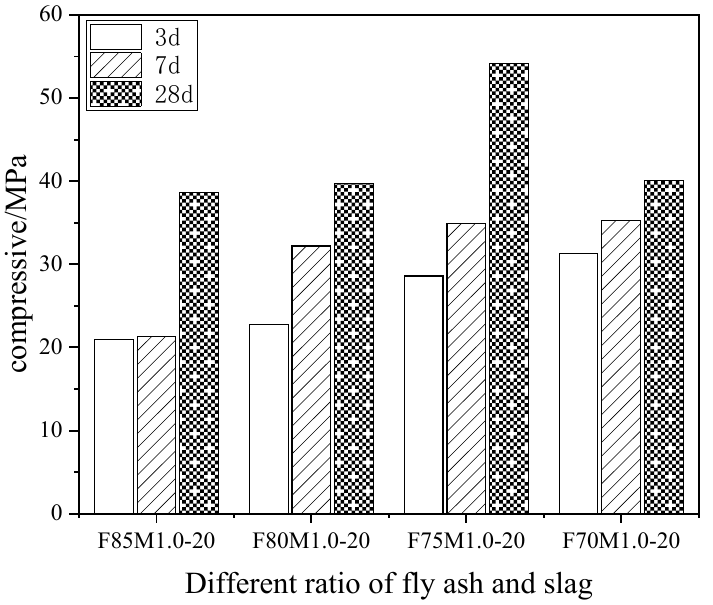
Figure 1. The effects of different fly ash content at different ages on the compressive strength of geopolymers.